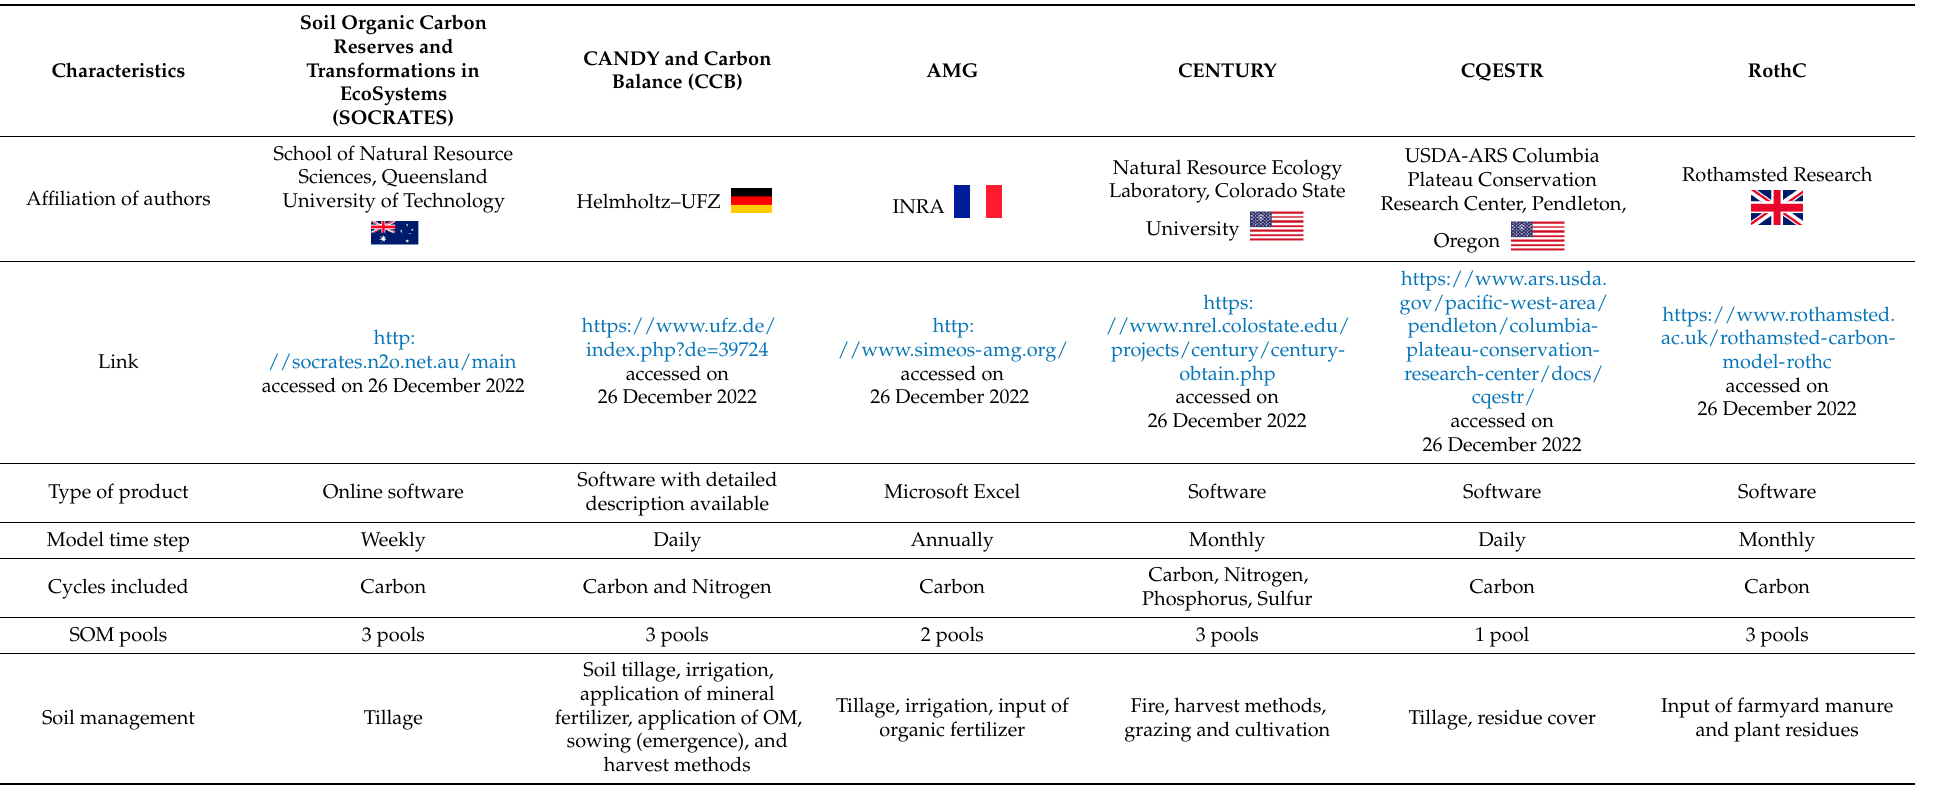
Table 2. Frameworks characterization showing its authors affiliation, type of product, model time step, cycles simulated, number of SOM pools included, type of management simulated, and the model scheme.